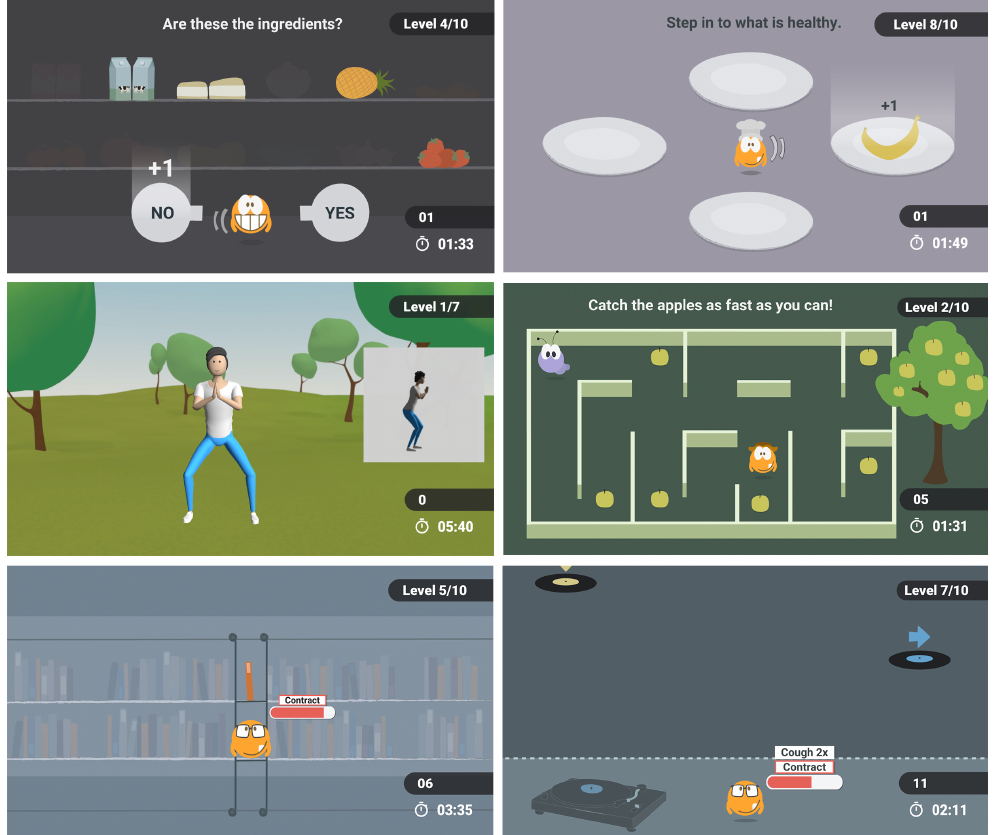
Figure 5. Six of the ten minigames. From left to right, top to bottom: Shopping list, Healthy food, Wide squats, Labyrinth, Falling books, and Music (the last two with the additional stimuli for pelvic floor muscle training in isolation or in coordination with a